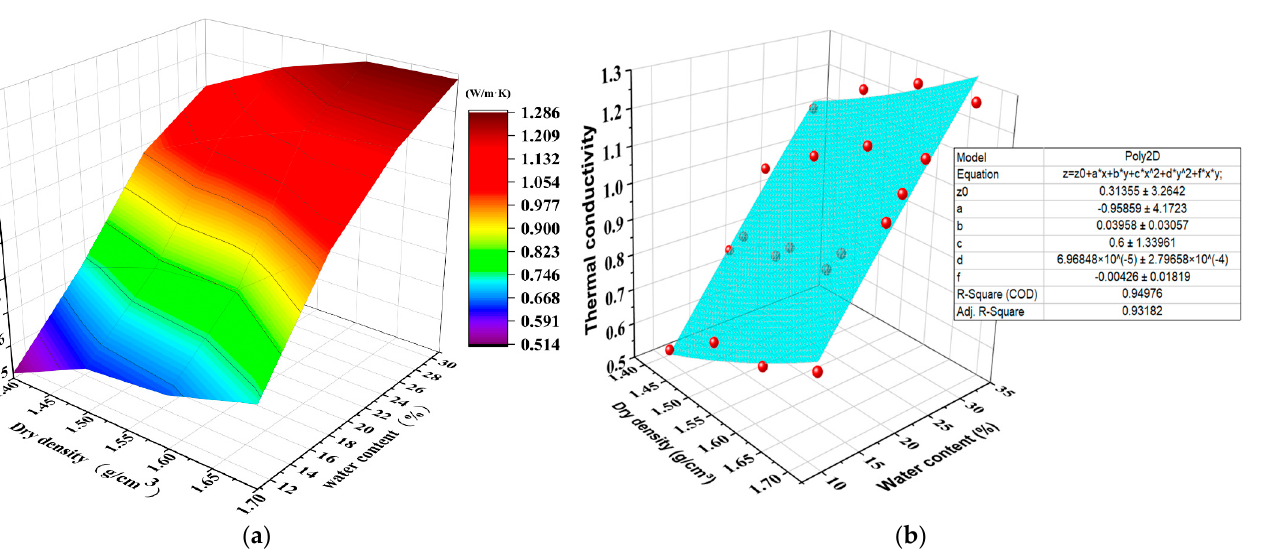
Figure 12. Thermal conductivity vs. water content relationship for various compacted bentonites.